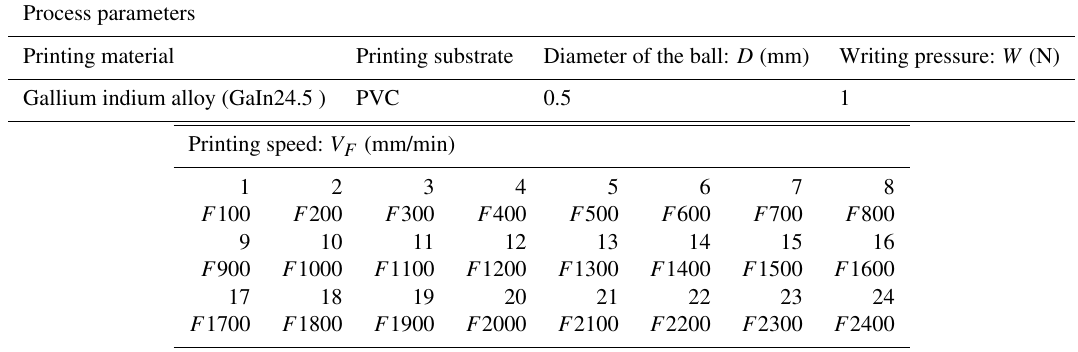
Table 1. Process parameters of direct-writing printing lines. Process parameters